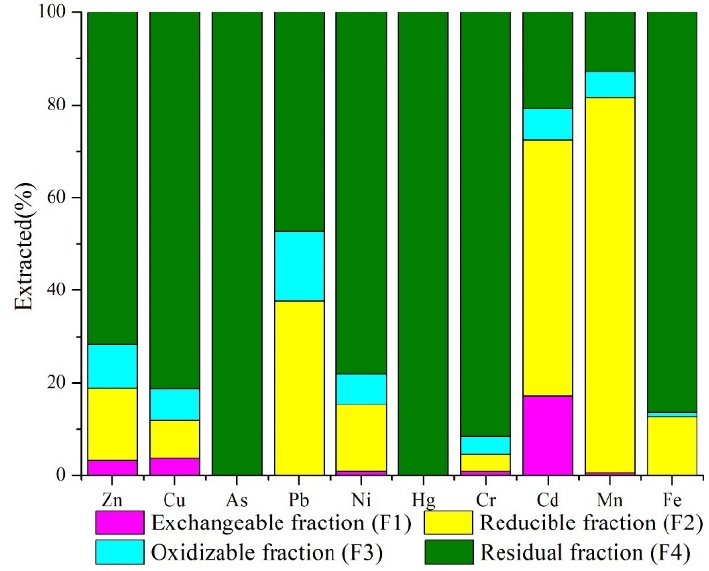
Figure 7. The percentages of metals chemical speciation in soils. The percentages of different Cd fractions for F1, F2, F3, and F4 were 17.24%, 55.17%,